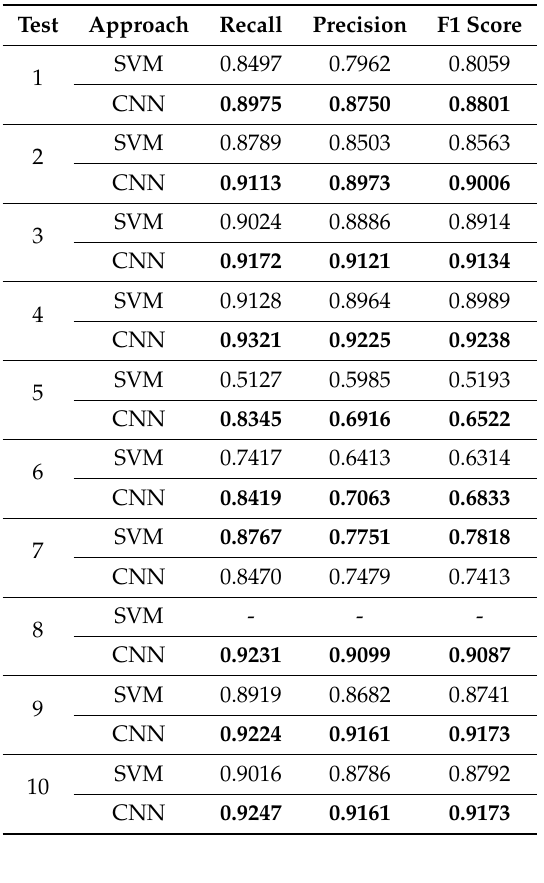
Table 3. The measure of the test for both approaches. Bold letters denote the winner technique